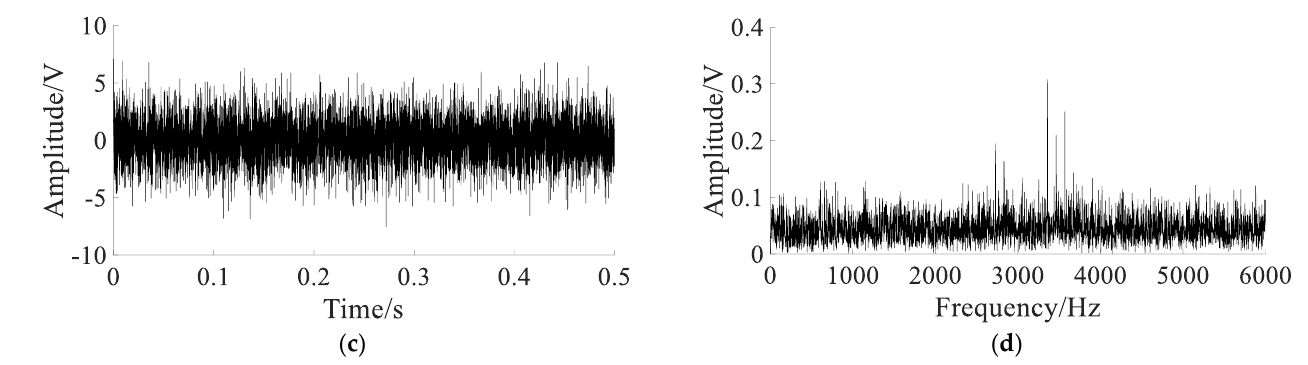
Figure 13. The bearing outer ring fault signals: ( a ) original signal; ( b ) spectrum of the original signal; ( c ) noisy signal; ( d ) spectrum of the noisy signal.